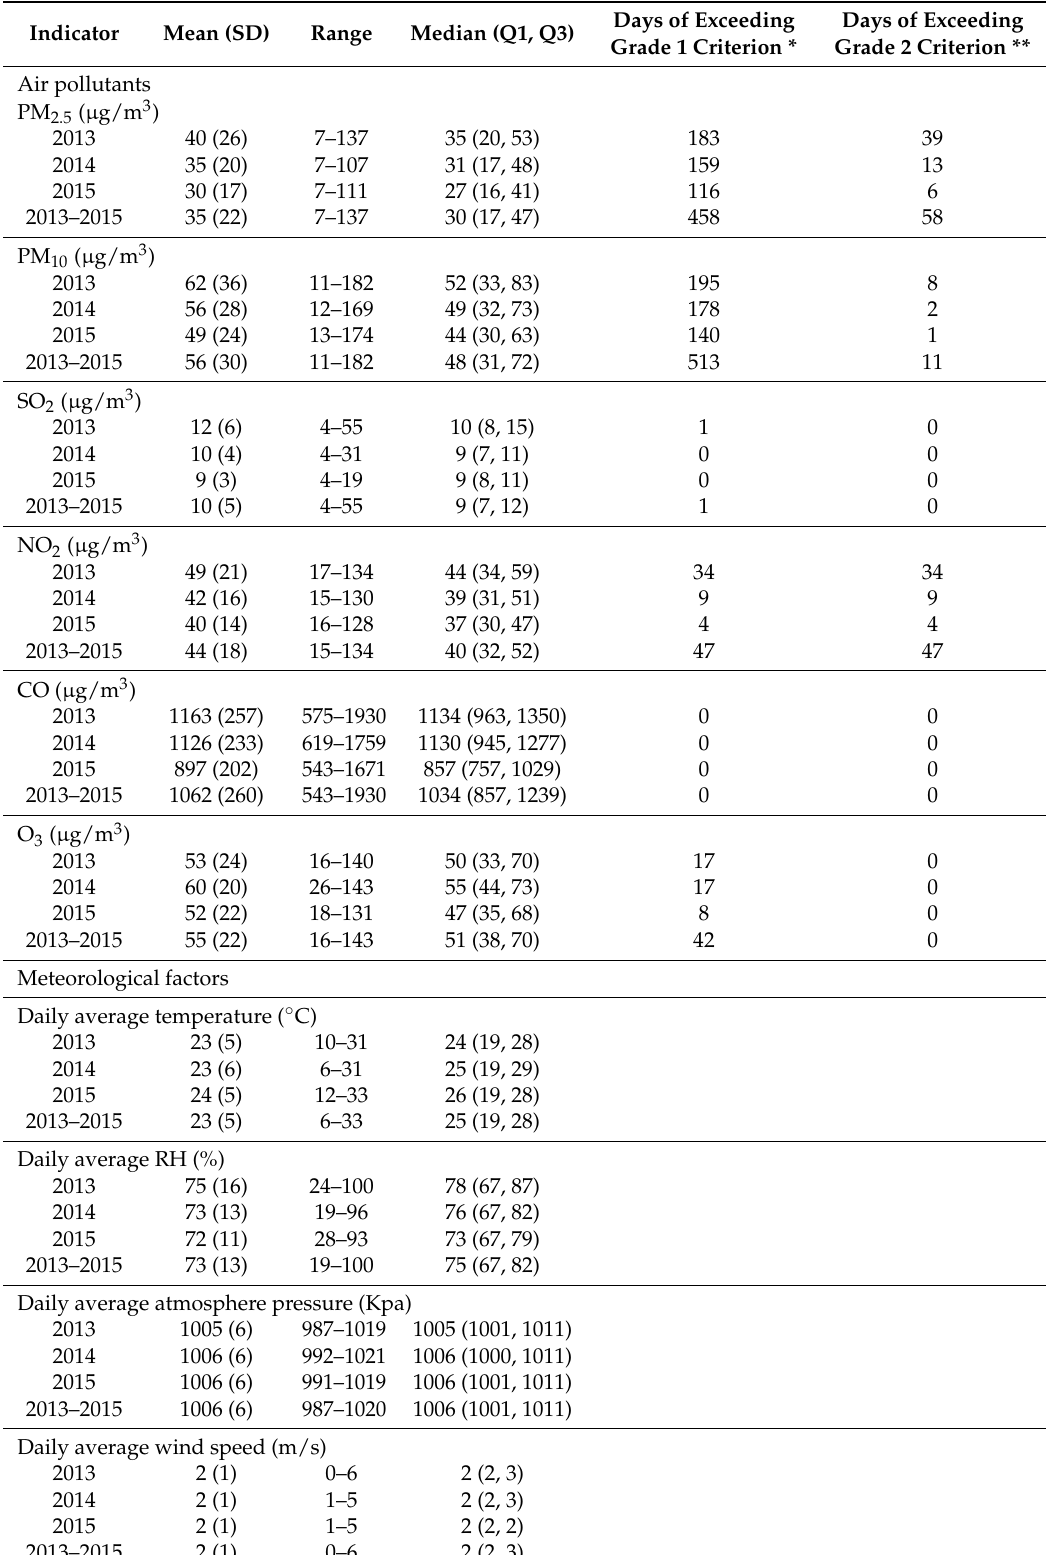
Table 2. Air pollutants and meteorological factors in Shenzhen